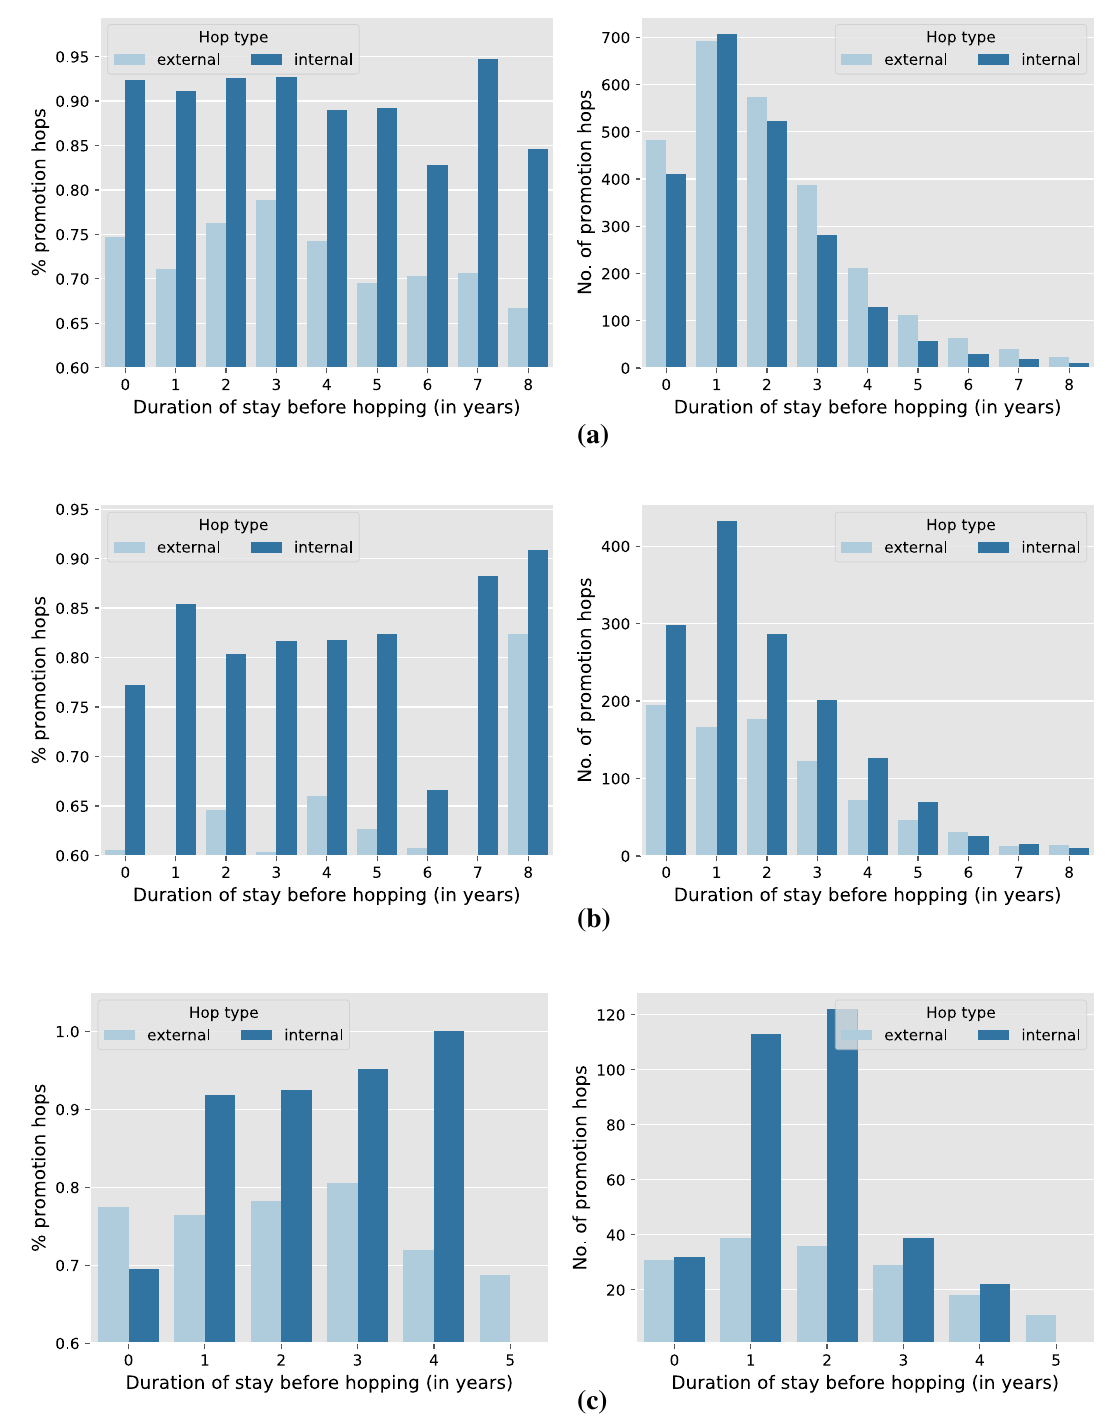
Fig. 12 Promotion hop fraction and counts for different durations of stay. a Singapore. b Switzerland. c Hong